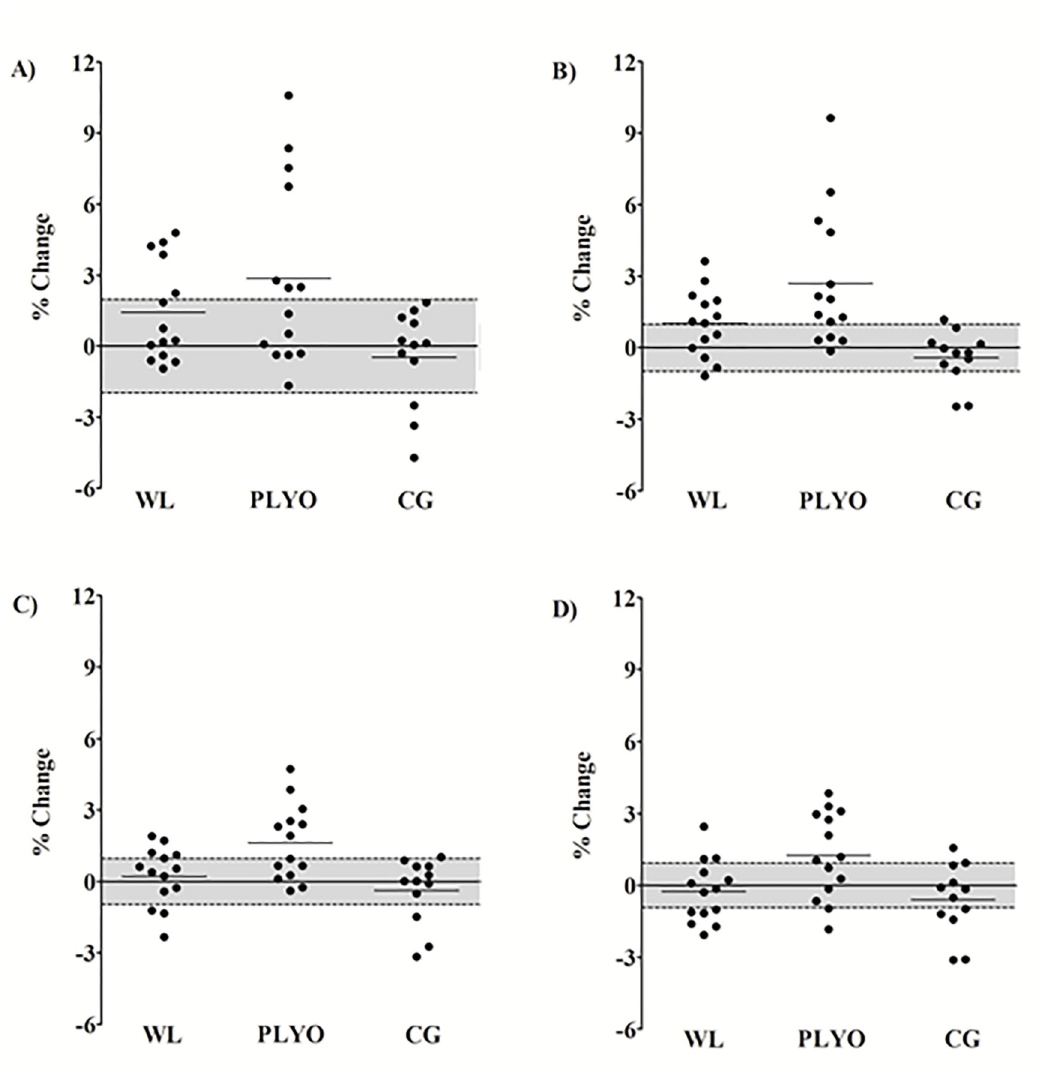
Fig 3. Sprint speed mean (horizontal lines ____ ) and individual (black circles) percentage changes from pre- to post-training. Grey area represents the coefficient of variation (%). A) sprinting speed 0–5 m, B) sprinting speed 0–10 m, C) sprinting speed 0–20 m, and D) sprinting speed 0–30 m. WL = weightlifting derivatives; PLYO = plyometric exercises; CG = control group.